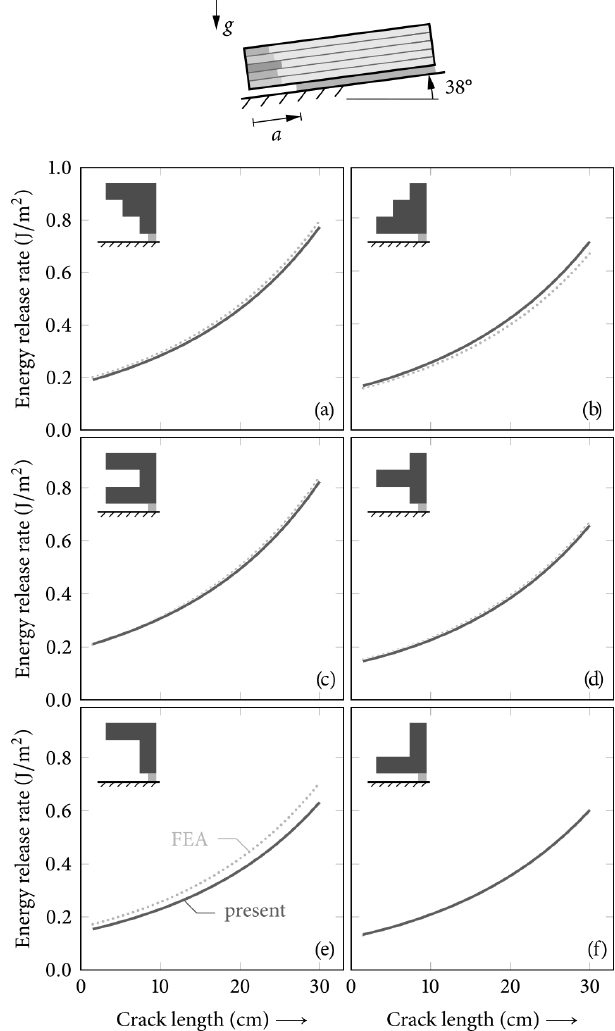
Figure 8. Weak-layer normal and shear stresses ( σ,τ ) owing to combined skier and snowpack-weight loading for the benchmark profiles illustrated in Fig. 5. The present solution (solid, dark) only slightly underestimates the maximum normal stresses with respect to the FEA reference (dotted, light) in the case of profile C. Ma- terial properties are given in Tables 1 and 2.